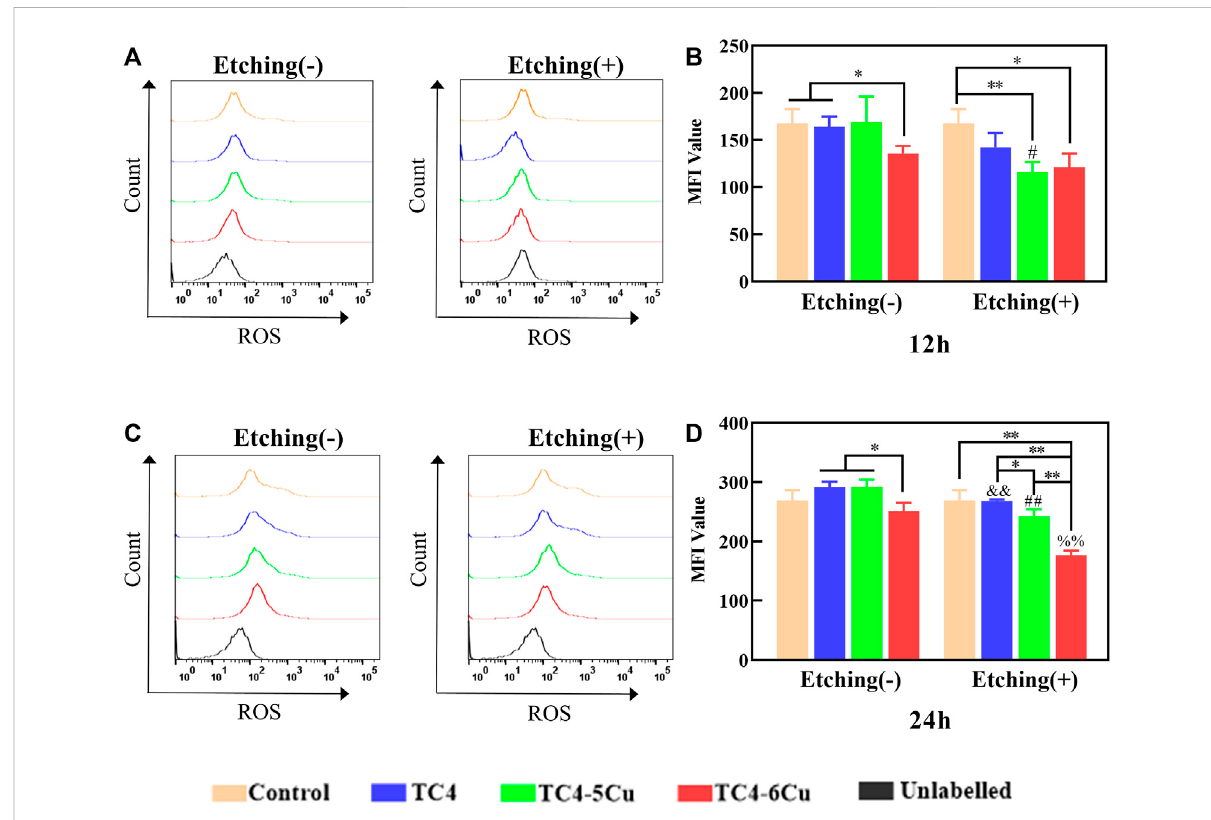
FIGURE 8 Flow cytometry analysis of intracellular ROS levels on RAW 264.7 cells in different material extracts for 12 and 24 h. (A,C) Expression of ROS in different alloy groups for 12 and 24 h; (B,D) quanti fi cation of mean fl uorescence intensity (MFI) of intracellular ROS level in different alloy groups for 12and24 h(n=3,NS:Nosigni fi cantdifference;* p < 0.05;** p < 0.01;and,comparedwithTC4alloy, p < 0.01;##,comparedwithTC4-5Cualloy, p < 0.01; %%, compared with TC4-6Cu alloys, p <